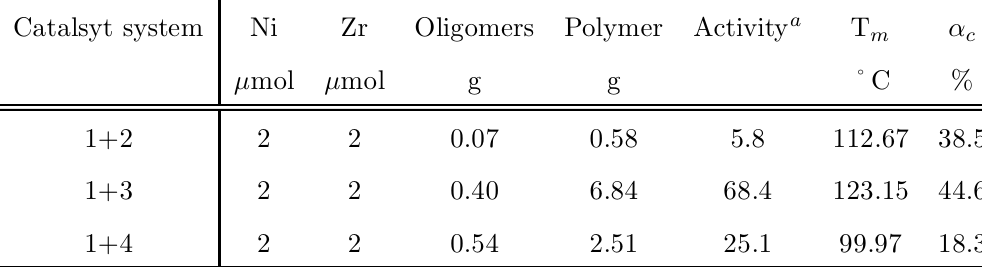
Table 4 The polymerization with di¬erent Zr